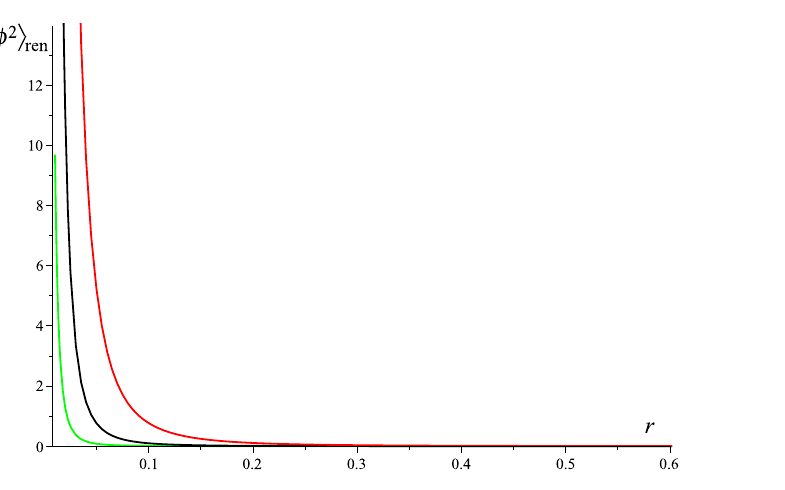
(cid:10) (cid:11) φ 2 as function of r for α = 1 (red), α = 10 (black) and α = 100 (green). ren